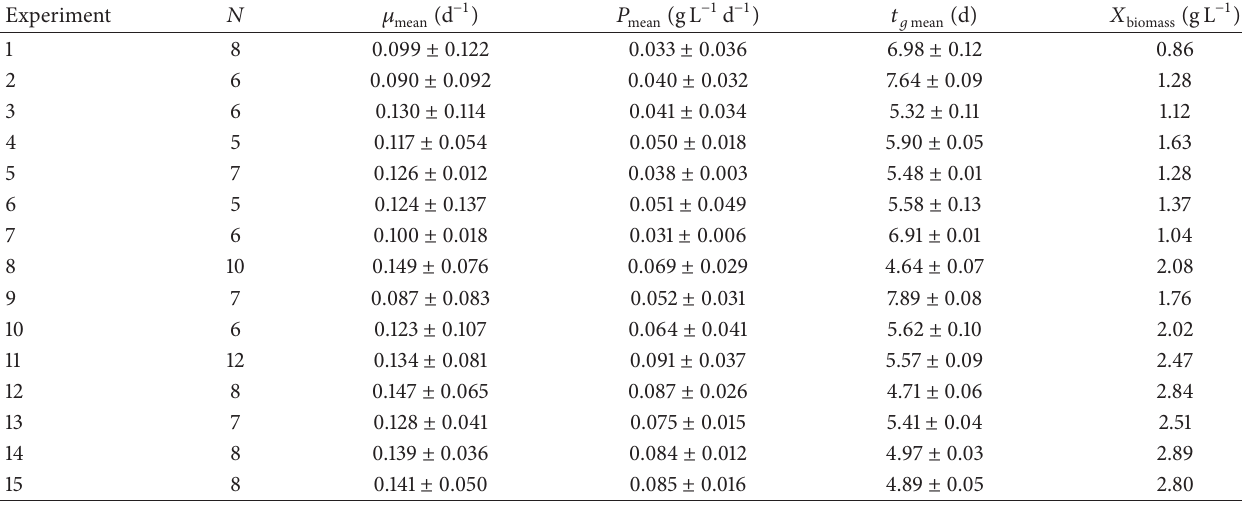
Table 2: Growth cycles ( 𝑁 ), mean specific growth rate ( 𝜇 ) for the Chlorella sp. microalgae cultivated in bioreactors open in semicontinuous mode. produced ( 𝑋 biomass Experiment